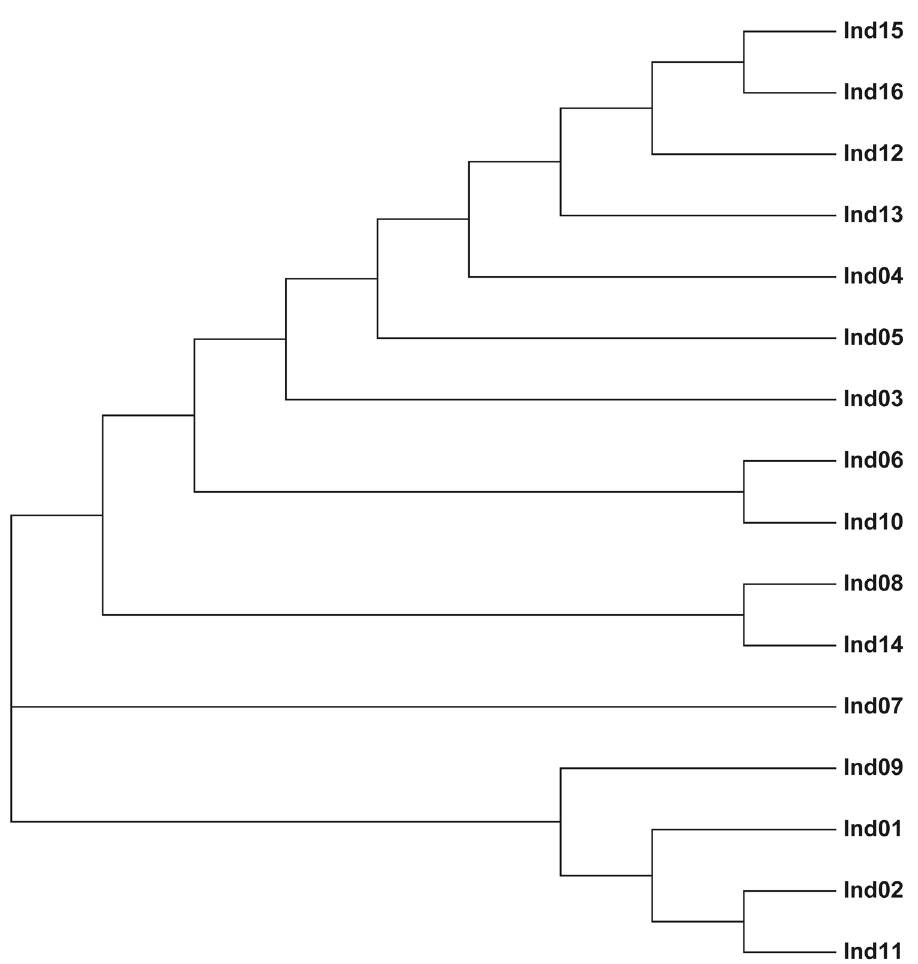
Figure 1. A dendrogram of 16 random individuals of sterlet was constructed using MEGA